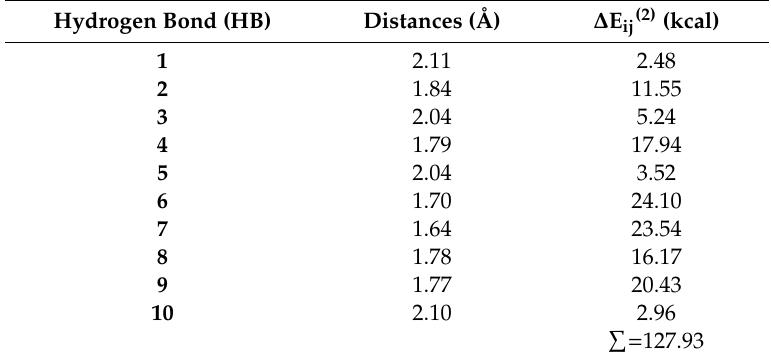
(cid:80) Total ) and for the hydrogen bonds